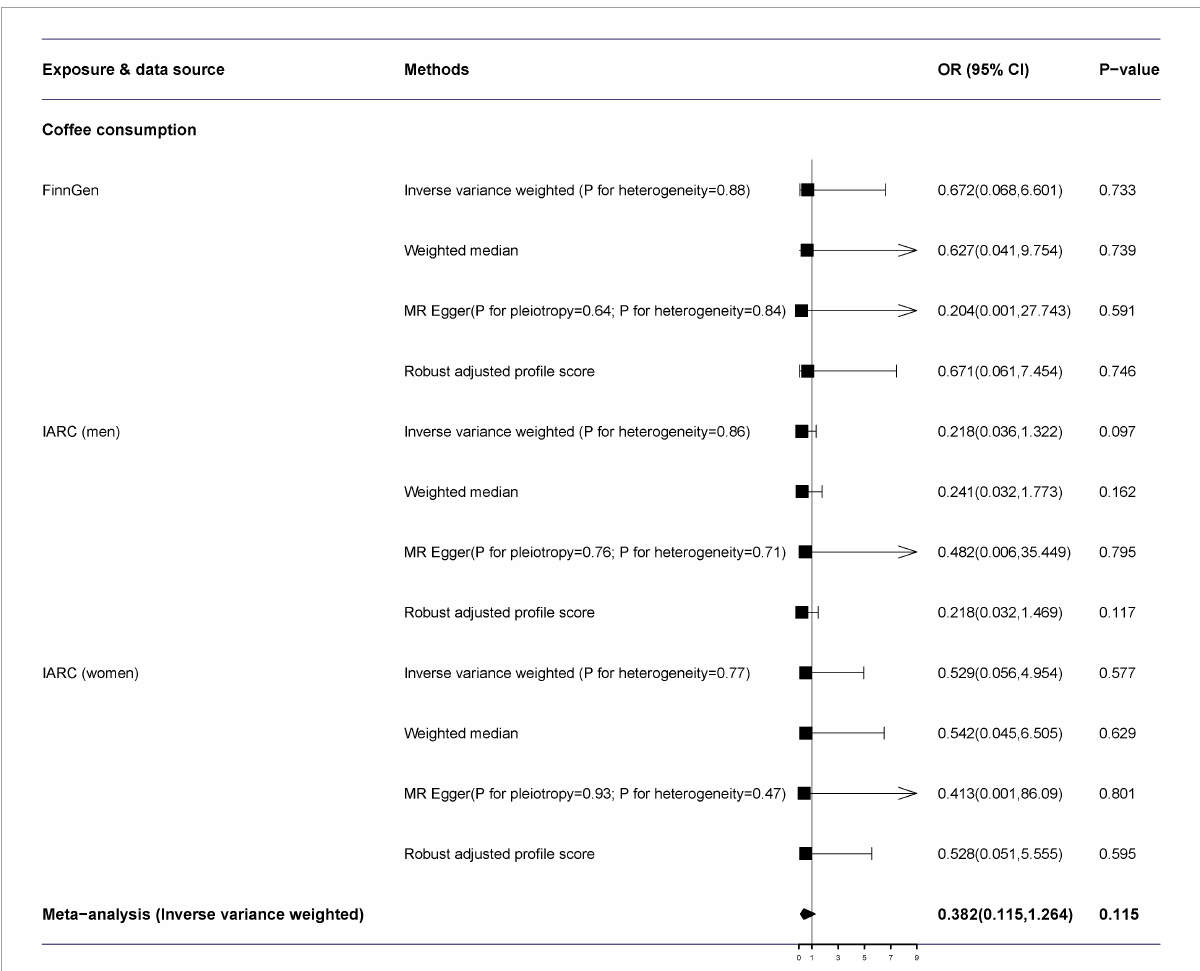
FIGURE3 Results of sensitivity analyses association of genetically predicted coffee consumption with renal cell carcinoma. Estimates were obtained from the inverse-variance weighted methods and combined using the fixed-effects meta-analysis methods. ORs for renal cell carcinoma were scaled to a genetically predicted 50% of increase in coffee consumption. FinnGen, FinnGen Consortium; IACC, the International Agency for Research on Cancer; OR , odds ratio; CI, confidence interval.